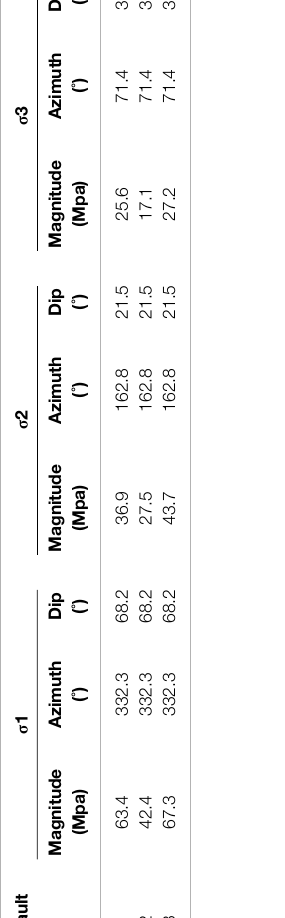
dipping toward the east at 55 ° (see pole/attitude diagrams in Figure 7B and Table 1 ). Derived fault geometric parameters were then used as input data to estimate the maximum expected earthquake magnitude for each fault assuming a reactivation where there is a seismic slip along their entire length. Based on the surface rupture length (SRL) and the underestimated rupture area (RA) and considering fault segmentation (i.e., for F1 and F2, see section 4.3 ), empirical scaling relationships (Wells and Coppersmith, 1994; Leonard, 2010) put forward a high seismic potential for the most continuous F3 faults capable of generating events exceeding magnitude 7 (see also Trippetta et al., 2019). ( Table 1 ). Even if fault reactivation depends on several parameters such us surface frictional characteristics, fault cohesion, shear normal stresses on the fault plane, and fl uid pressure, potential reactivation of faults has been here evaluated through a slip tendency analysis (Morris et al., 1996), which de fi nes the propensity of a surface to undergo slip when a stress is applied. Slip tendency (T s ) is based on Amonton ’ s law which governs the slip of a cohesionless plane and is expressed by the shear/normal stress ratio acting on the surface (Morris et al., 1996). The formulation is Ts (cid:2) τ / σ ′ n , where τ is the shear stress and σ ′ n is the effective normal stress (i.e., the normal stress minus fl uid pressure) acting on the plane. Following the assumptions proposed in the Wallace – Bott hypothesis (Wallace, 1951; Bott, 1959) and using the stress analysis tools of Move 2019.1 software (Petex Ltd.), stress fi eld tensors orientation derived from slip-data inversion (see Stress Field ) were remotely applied to the modeled fault surfaces ( Figure 7 ). Considering an average density 2,600 and 1050 kg/m 3 for the overburden rocks and seawater, respectively, and approximating the maximum stress ( σ 1 ) to the lithostatic load, a con fi ning stress is resolved at a mean depth in the medium around each fault (see applied stress and relative pressure pro fi les for each fault in Figure 8 right panels and in Figure 8 ) found that Table 2 ). Slip tendency computation (T s in the F3 as the fault structure most prone to be reactivated along its entire length with the highest average T s value (0.90) homogeneously distributed along the fault plane ( Figure 8A ). F2 also exhibits a high mean T s value of 0.83 with a maxima (T s (cid:2) 1) reached mainly on the southern portion of the fault plane ( Figure 8B ). Conversely, F1 shows the lowest average T s value (0.71) with a maxima (T s (cid:2) 1) occurring over limited and shallow portions of the fault plane mainly off Siracusa and Augusta ( Figure 8C ). Additionally, the fault displacement analysis (see Fault Displacement Analysis and Deformation Rate ) suggests segmentation of the F1 and F2 faults (i.e., the double bell- shaped displacement pattern, see Figure 5C ), suggesting these structures have grown following a segment linkage pattern. Accordingly, a lower seismic potential should therefore be applied to these tectonic structures. Conversely, fault displacement analysis revealed that the F3 fault structure has grown in a radial way since at least the Pleistocene whereby its seismic potential has likely not been overestimated. T A